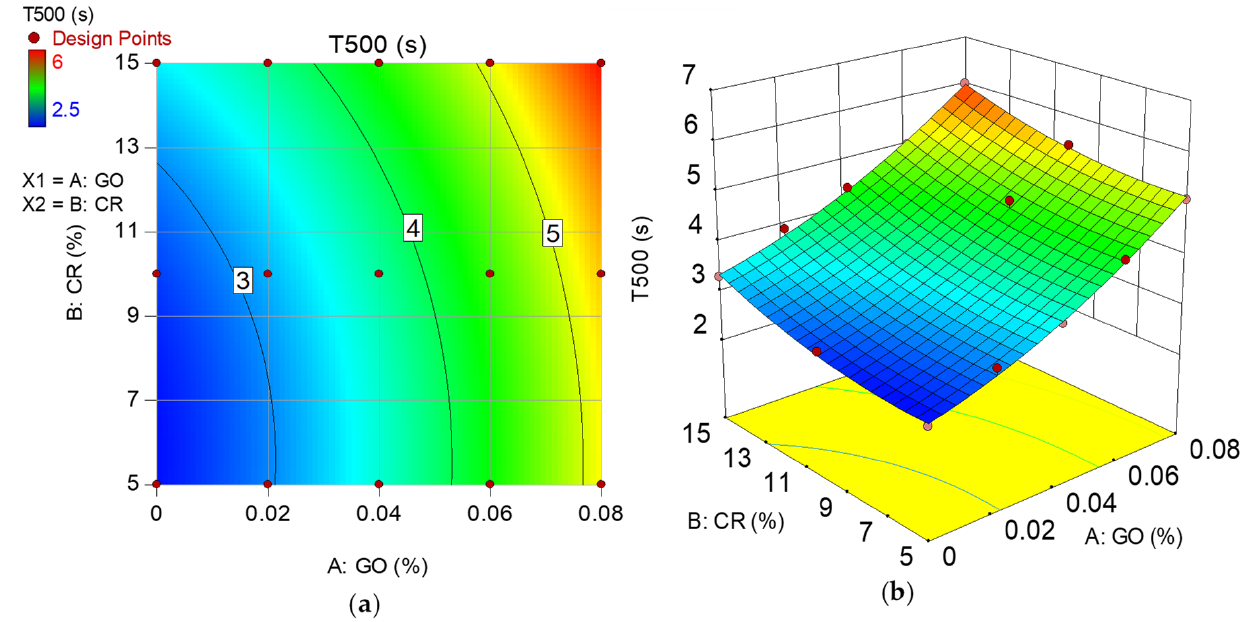
Figure 8. ( a ) 2D contour plot and ( b ) 3D response surface diagram for T 500 .